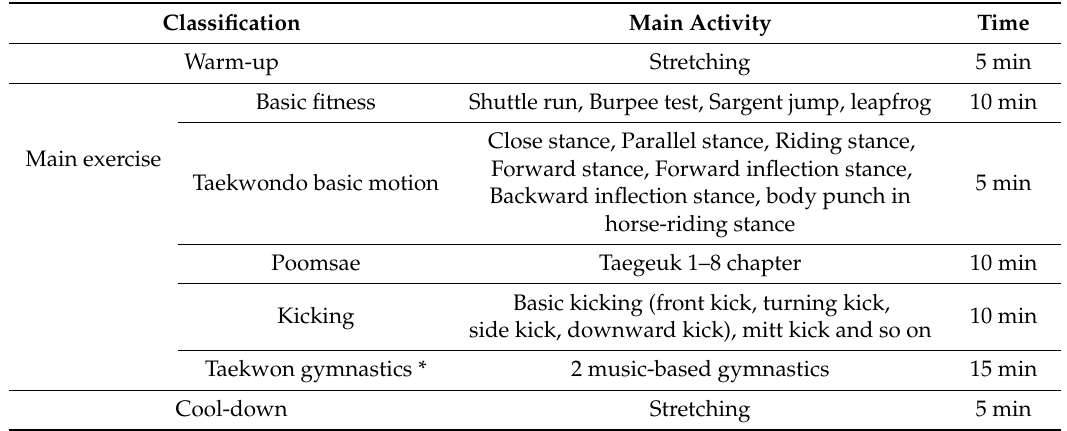
Table 2. Taekwondo-based training programs. Classification Main Activity Time Warm-up Stretching 5